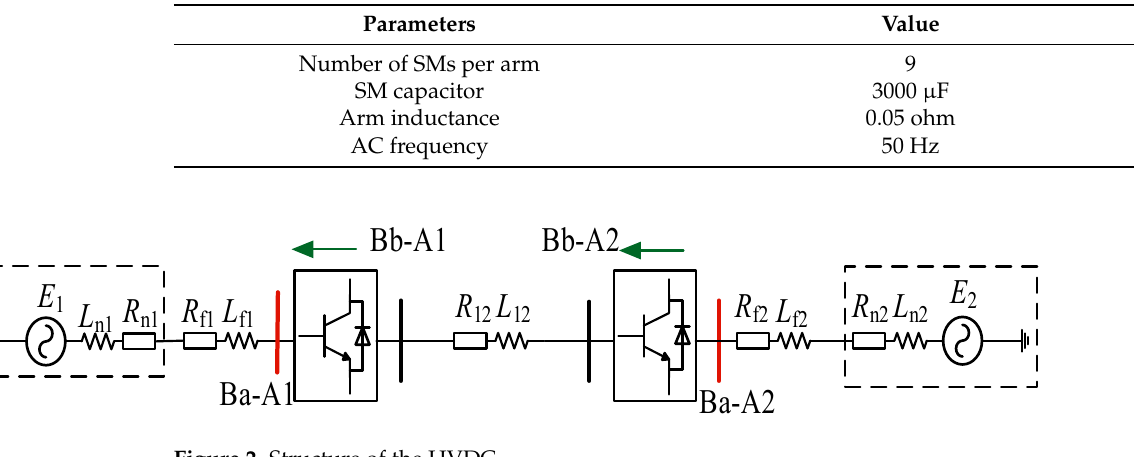
Figure 2. Structure of the HVDC.